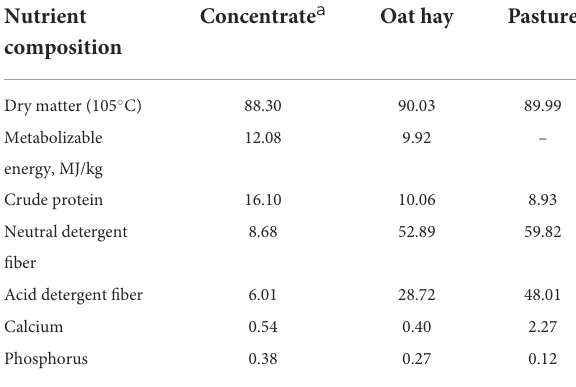
TABLE 1 Nutrient composition of the concentrate, oat hay, and natural pasture (% of dry matter). Nutrient